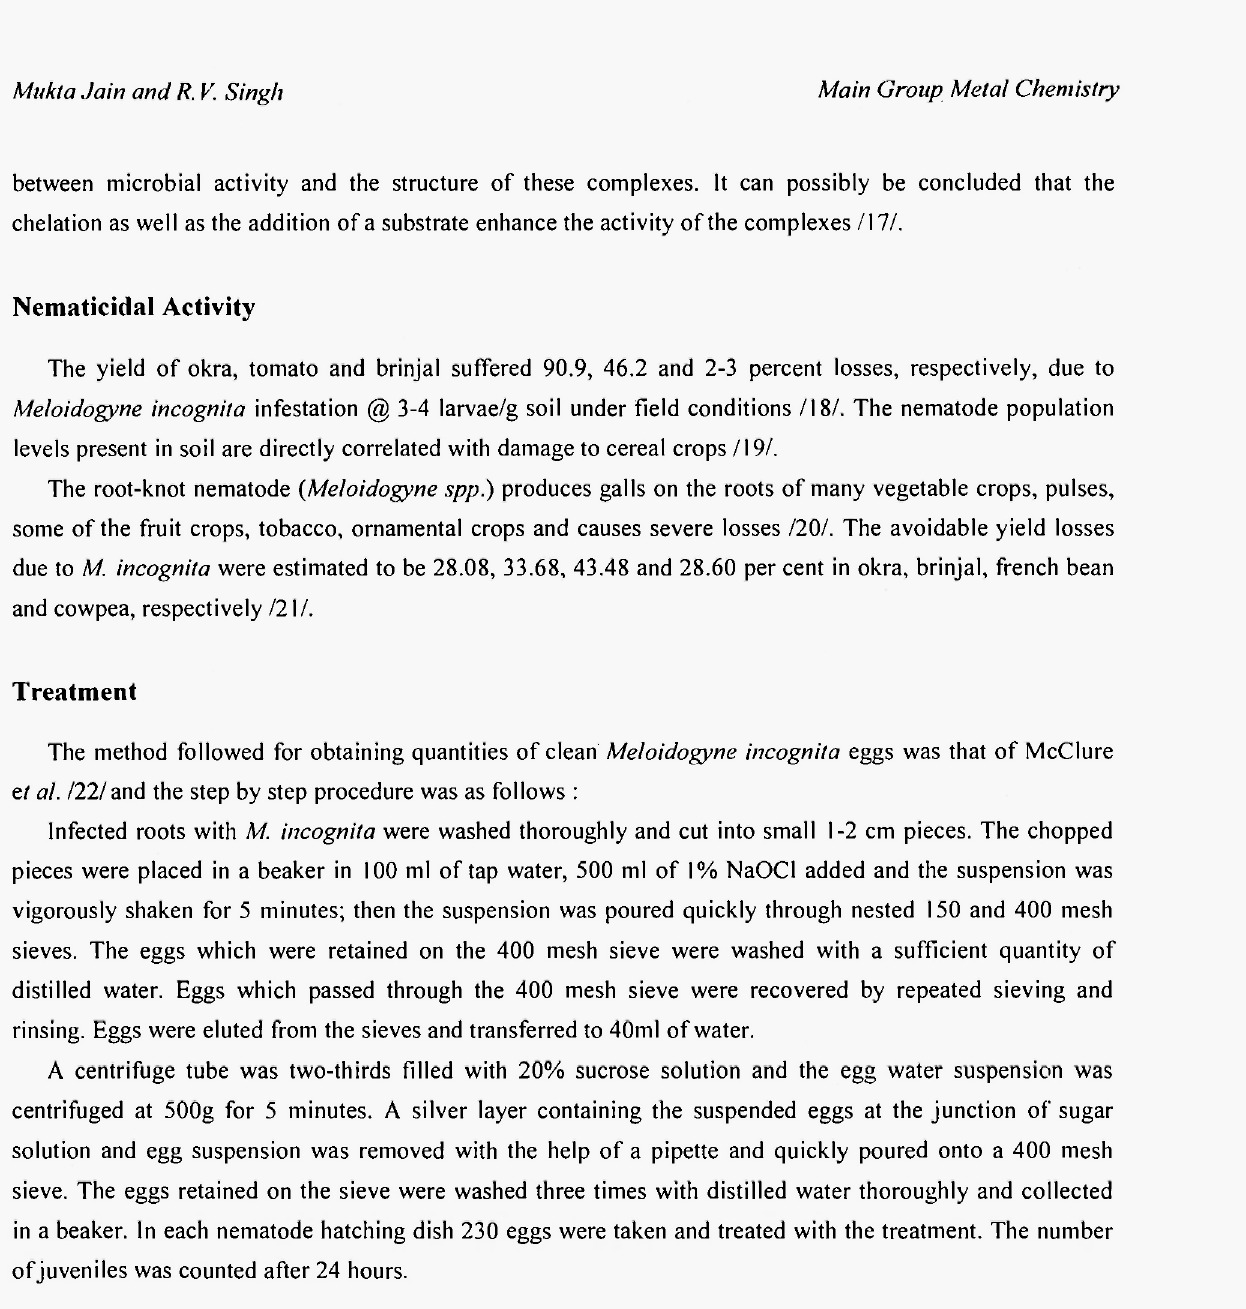
Nematicidal activity of the ligand and its silicon complexes (percentage of hatching in Meloidogyne